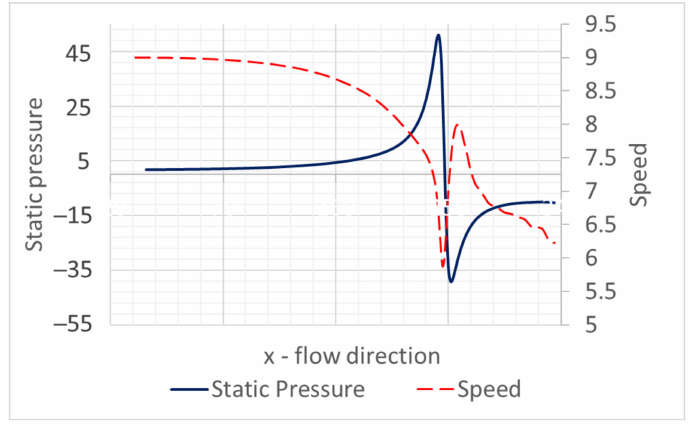
Figure 5. Static pressure and speed around wind turbine rotor on a line across the wind turbine